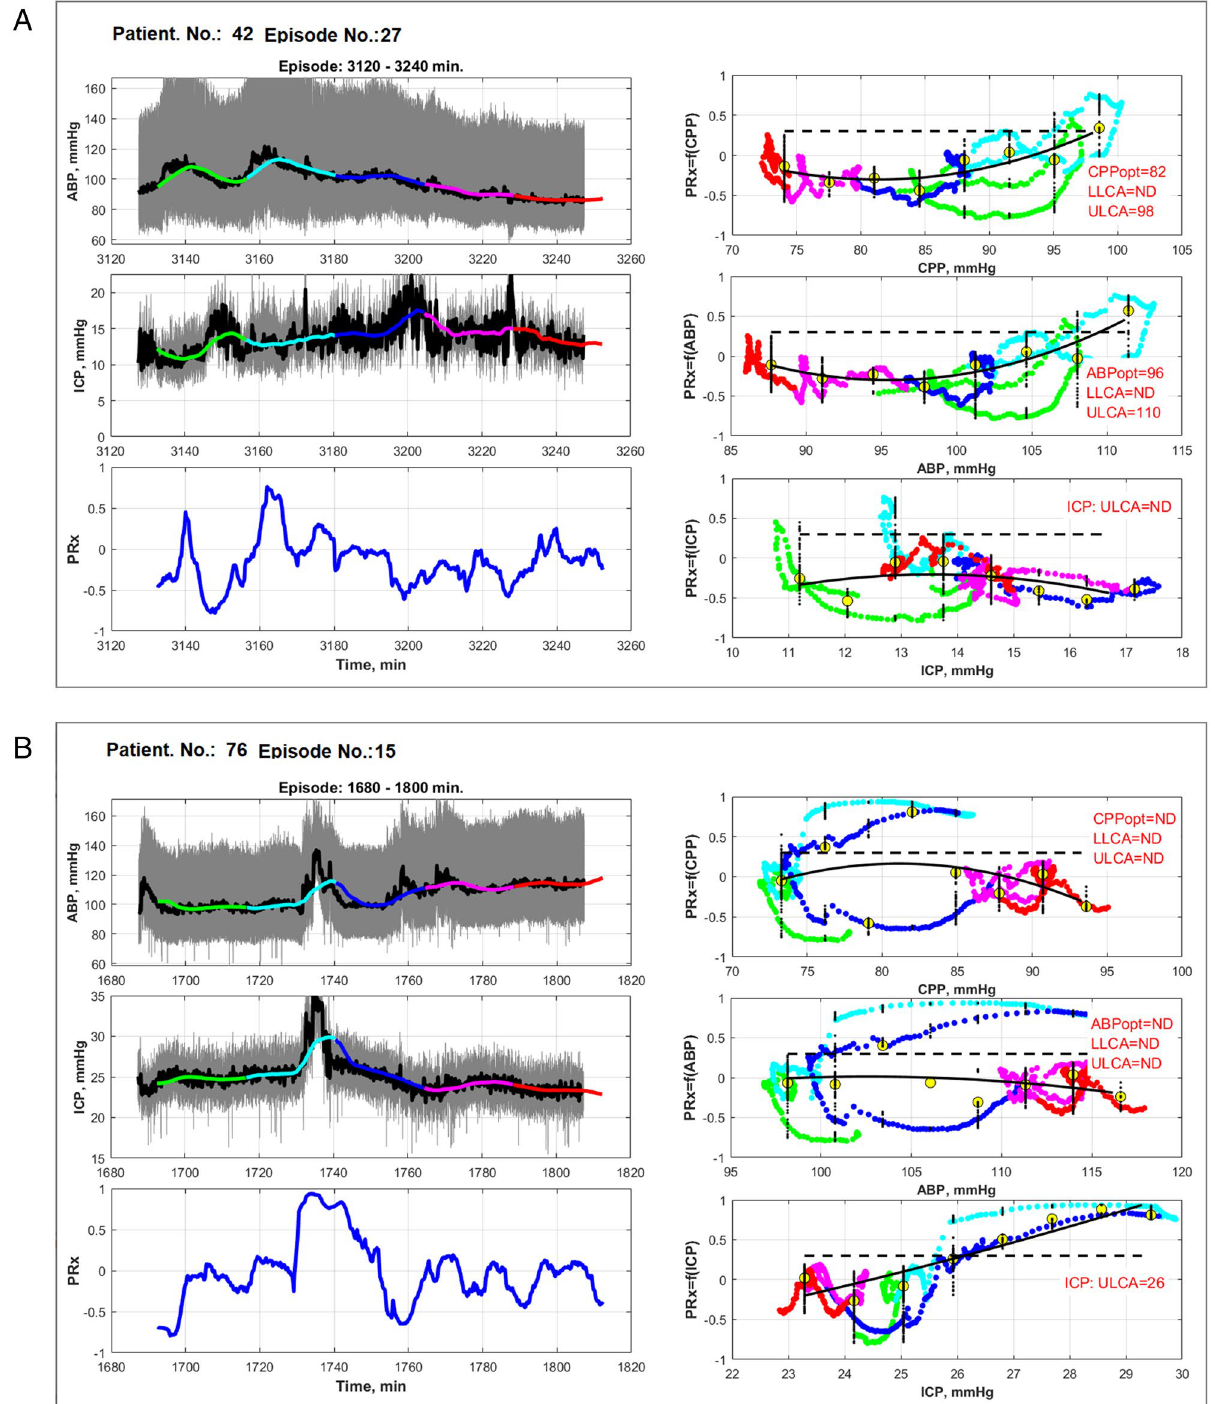
Figure 2. Software tool for ICU multimodal monitoring data analysis and CPPopt identification. The contribution of ABP and ICP color-marked episodes (i.e., green, cyan, blue, pink and red) to the formation of quadratic approximation curves can be analyzed by including or removing them from the PRx = f(CPP), PRx = f(ABP), and PRx = f(ICP) graphs. Color-marked segments are selected from software menu by assigning segments into “artifact-free”/”artifact-disturbed” or “informative”/”noninformative” classes which are required to train and test the ML algorithms. The example in ( A ) represents the case when CPPopt and ABPopt together with the upper limits of autoregulation (ULCA) are identified, thus demonstrating that CPPopt-targeted treatment can be applied for the personalized management to control intact CA. The example in ( B ) shows that CPPopt identification can be disturbed due to an ICP increase. However, the detected ULCA for ICP shows that ICP increase above 26 mmHg leads to impaired CA. Here ND is “not